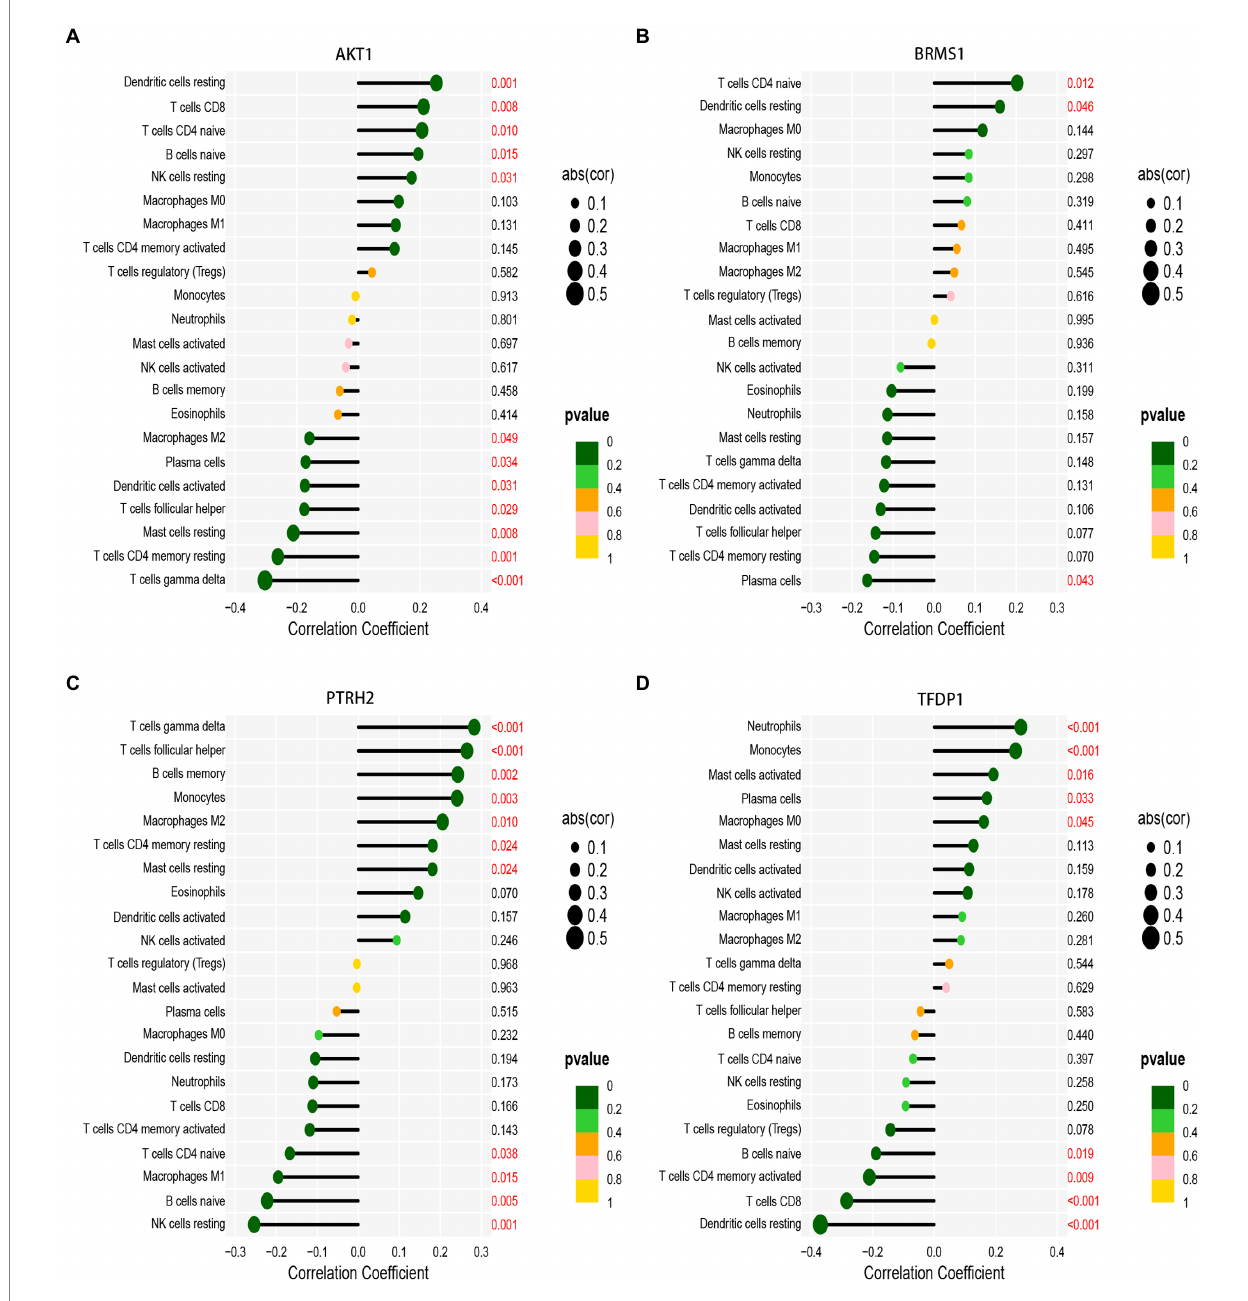
FIGURE 9 Correlation analysis of immune infiltration with signature gene expression in the combined database of GSE58294 database and GSE16561 database. (A) The correlation of AKT1 gene expressions with immune infiltration cell. (B) The correlation of BRMS1 gene expressions with immune infiltration cell. (C) The correlation of TFDP1 gene expressions with immune infiltration cell. (D) The correlation of TLE1 gene expressions with immune infiltration cell. The size of the dots represents the strength of gene correlation with immune cells; the larger the dot, the stronger the correlation. The color of the dots represents the p -value; the greener the color, the lower the p -value. Numbers marked in red indicate statistical significance. p < 0.05 was considered statistically